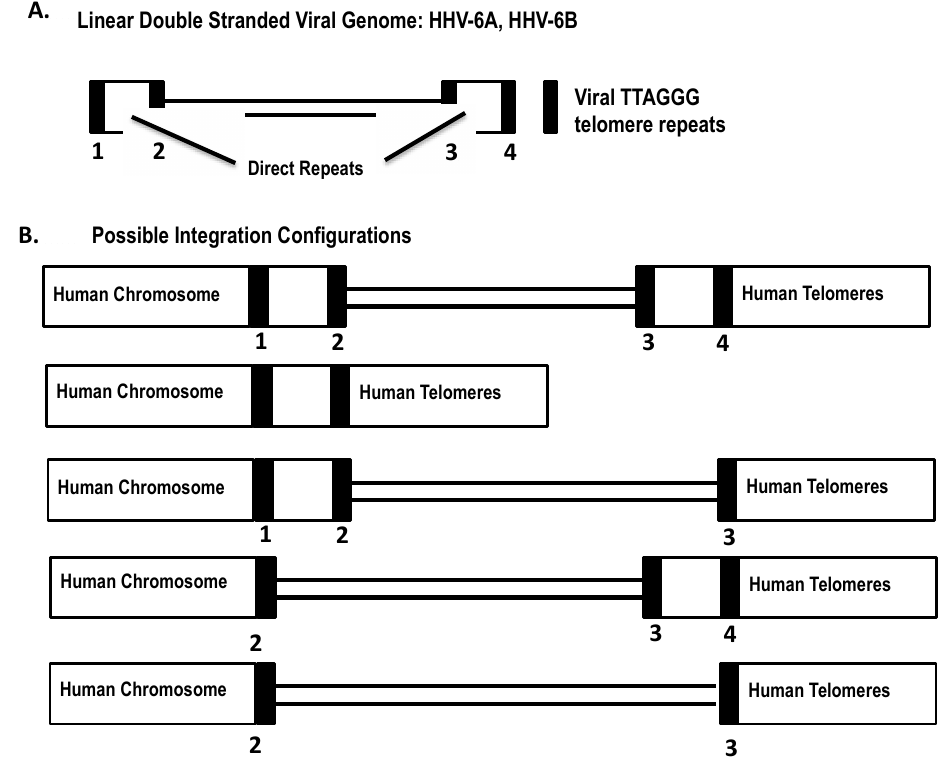
Figure 3. Possible integration configurations of the HHV-6 genome. ( A ) The HHV-6 genome contains four telomere-like repeats flanking the direct repeats; ( B ) Integration of the HHV-6 genome by recombination with the host telomeres can potentially occur at either of the four telomere repeats and five possible integration configurations may be generated.